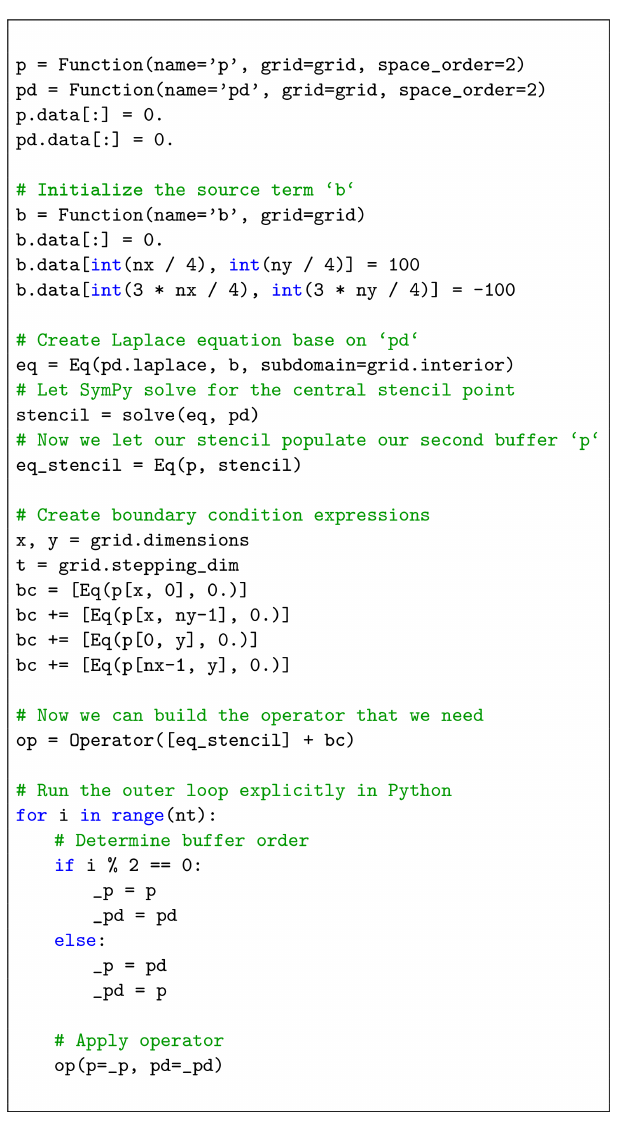
Figure 18. Poisson equation in Devito with field swap in Python.